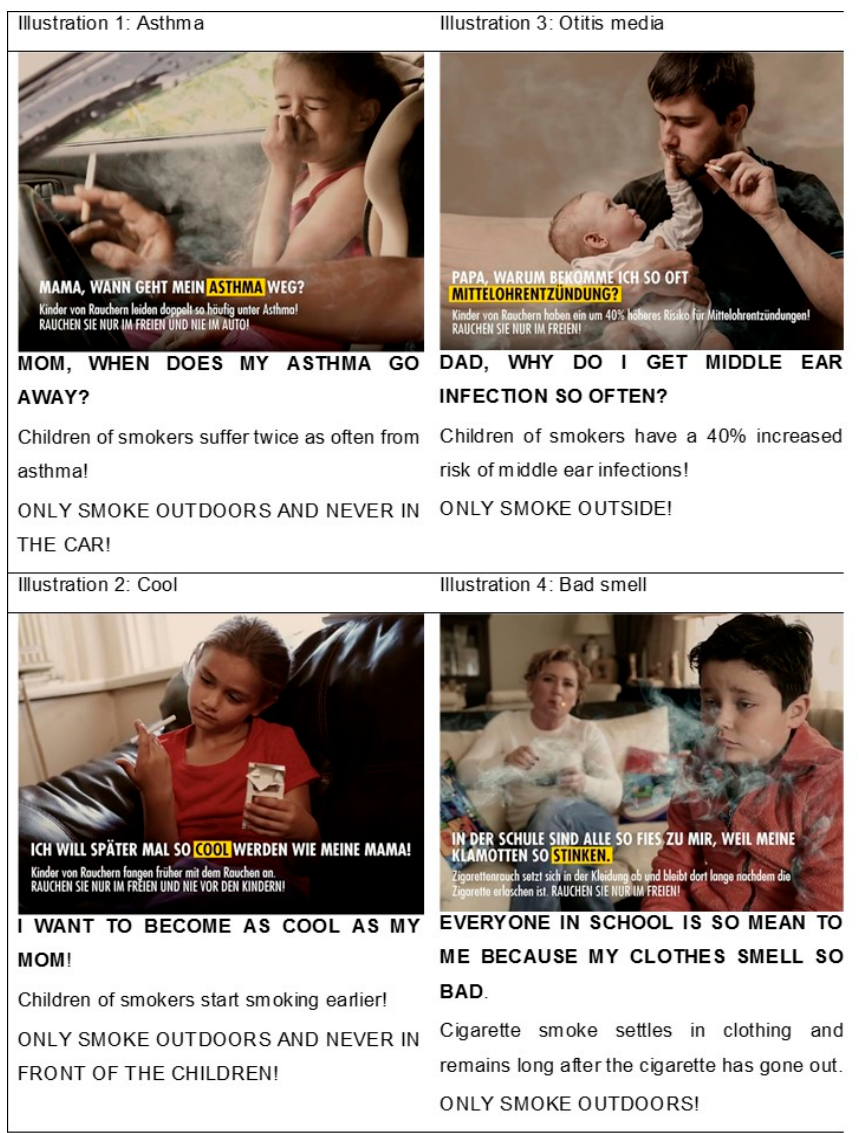
Figure 1. Pictures with key messages of the final campaign (Original in German with English translation provided below). MP4 files with the voiceover can be found at http://www.klinikum.uni-muenchen.de/Institut-und-Poliklinik-fuer-Arbeits-Sozial-und-Umweltmedizin/de/forschung/ arbeitsgruppen/Prof__Radon/aktuelles/Passivrauchkampagne.